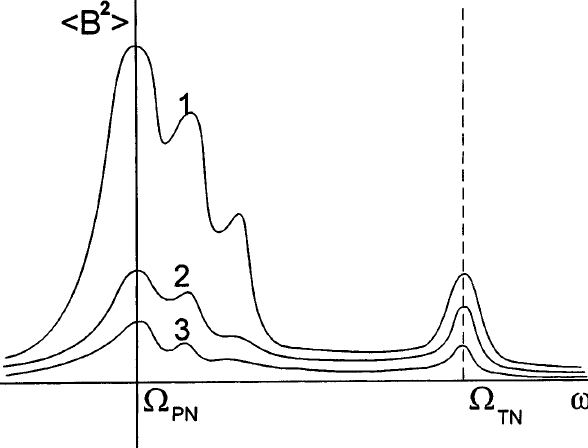
Fig. 3. Schematic diagrams of spectral density for components of a disturbed magnetic field in the case of a large attenuation (cid:133) (cid:109) N (cid:29) 1